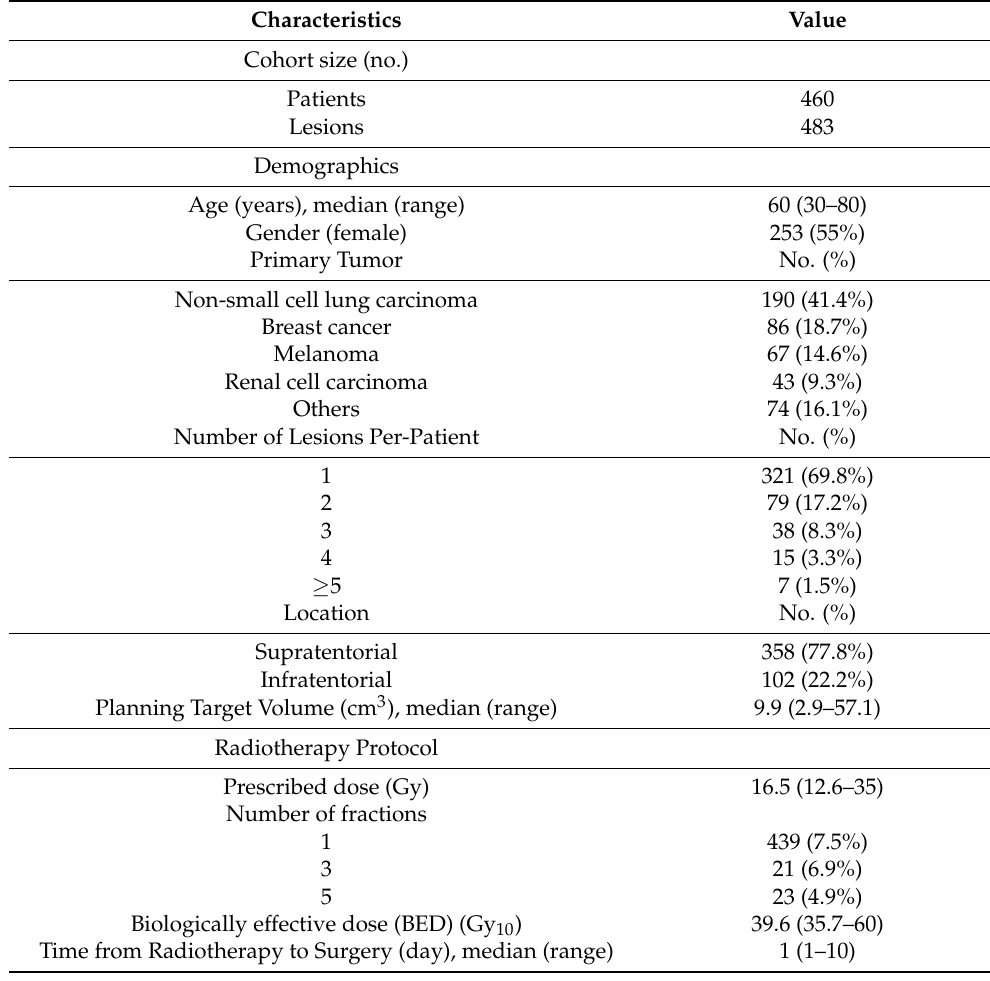
Table 2. Summary of clinical characteristics, treatment protocols, and pooled